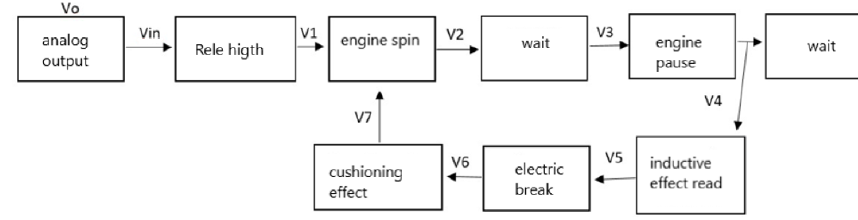
Figure 13. Flowchart of the operation of the ‘Automatic Equipment’.